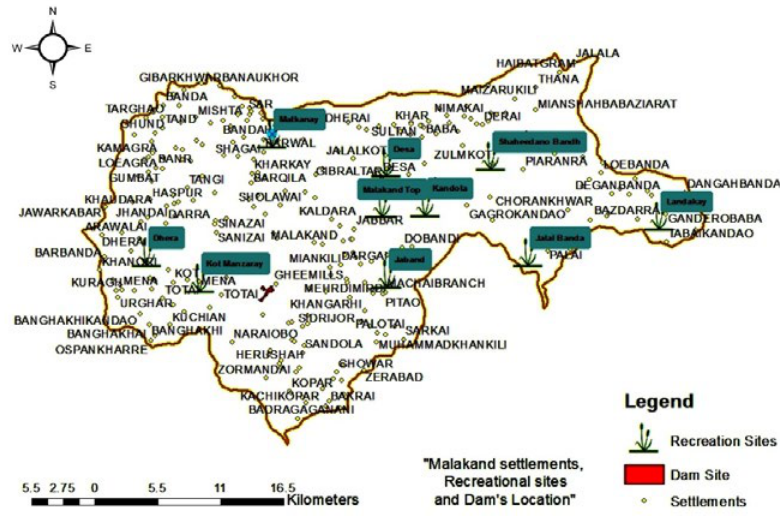
Fig. 8. Recreational sites and settlements Fig. 8: Recreational sites and settlements